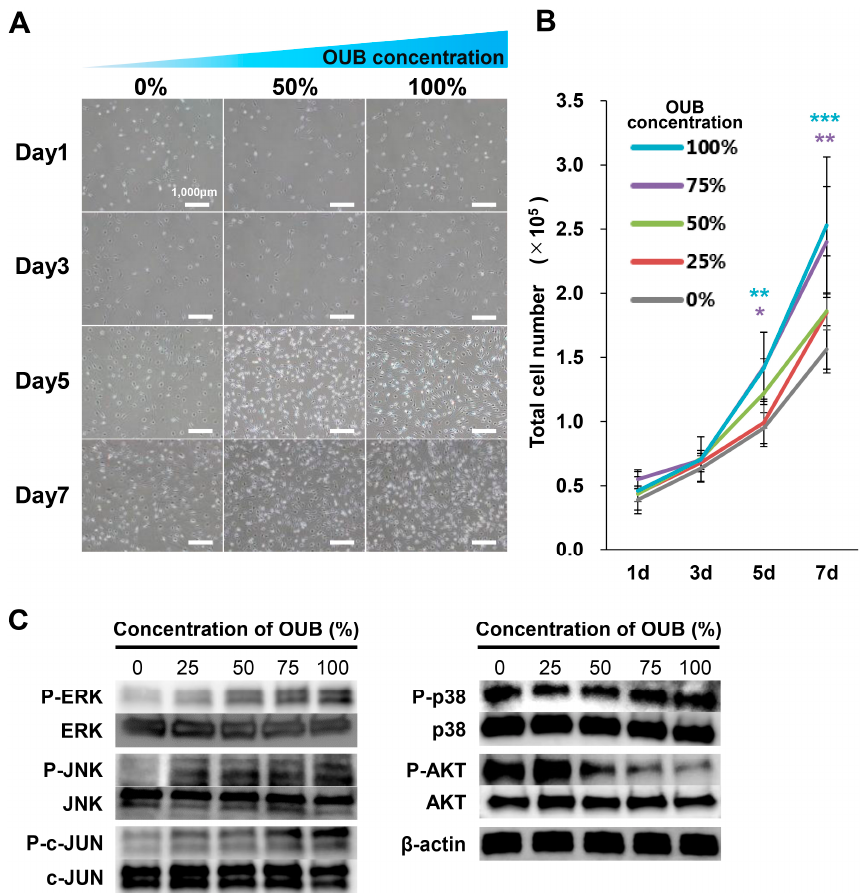
Figure 4. OUBs stimulate the proliferation of SCs. ( A ) Representative micrographs of SCs cultured at 1, 3, 5, and 7 days in OUBs diluted in growth medium (concentration 0, 50, and 100%). Scale bar = 1000 μ m; ( B ) quantification of the total cell number of SCs in OUBs diluted in growth medium (concentration 0, 25, 50, 75, and 100%); ( C ) western blotting of the proliferation and di ff erentiation related signals in SCs cultured in OUBs diluted in growth medium for 30 min (concentration 0, 25, 50, 75, and 100%). β -actin was used as an internal control. The data were analyzed by one-way ANOVA followed by Dunnett test. Graphs show mean ± SD. Results are representative of more than four independent experiments. * p < 0.05, ** p < 0.01, *** p < 0.001 compared with 0% group. OUBs: oxygen ultra-fine bubbles, SCs: Schwann cells, ERK: extracellular signal-regulated kinase, JNK: c-Jun-N- terminal kinase.